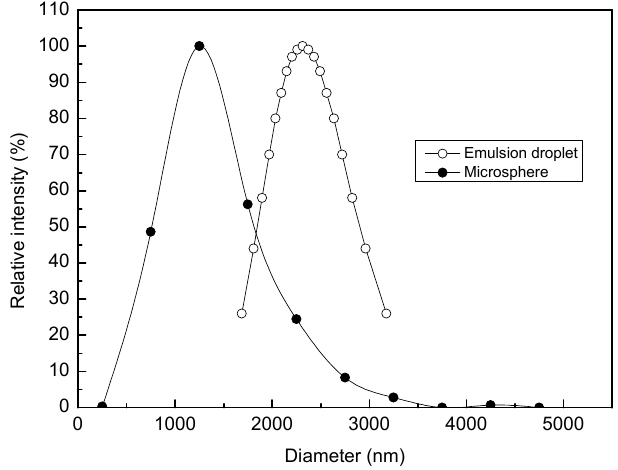
Figure 2. Diameter distribution of the polyamine microsphere and the emulsion droplet used as the template for